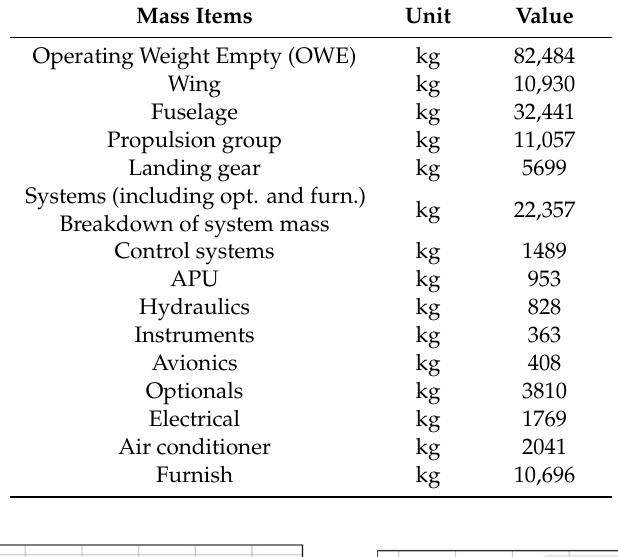
Table A2. Initial Weight break-down of SE²A-LR calculated using SUAVE.